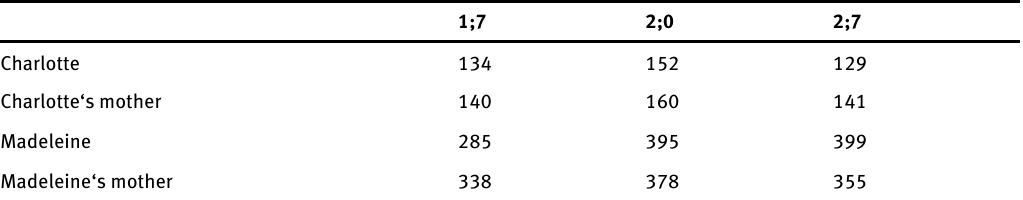
Table 1: Number of turns produced by the two children per hour at 1;7 and 2;0 and 2;7 1;7 2;0 2;7 Charlotte 134 152 129 Charlotte‘s mother 140 160 141 Madeleine 285 395 399 Madeleine‘s mother 338 378